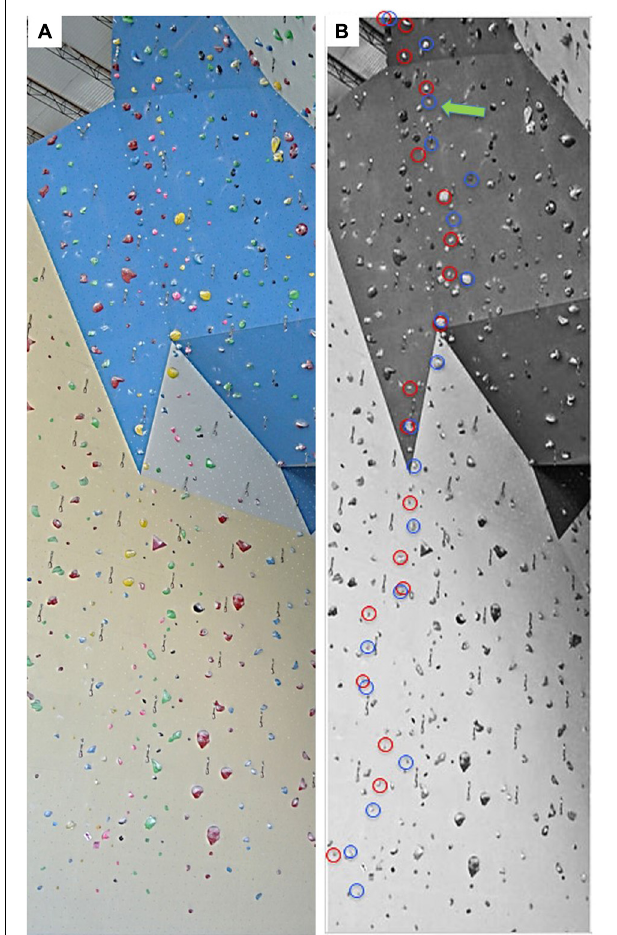
FIGURE 1 | Artificial indoor climbing wall with one of the routes used for the test (yellow, 7b) (A) . The black and white image (B) is the same image as the one shown to the climbers before and after the on-sight and the red-point ascent. The handholds that climbers planned to grasp are circled (red = left hand, blue = right hand). The green arrow indicates the spot where a climber expected to